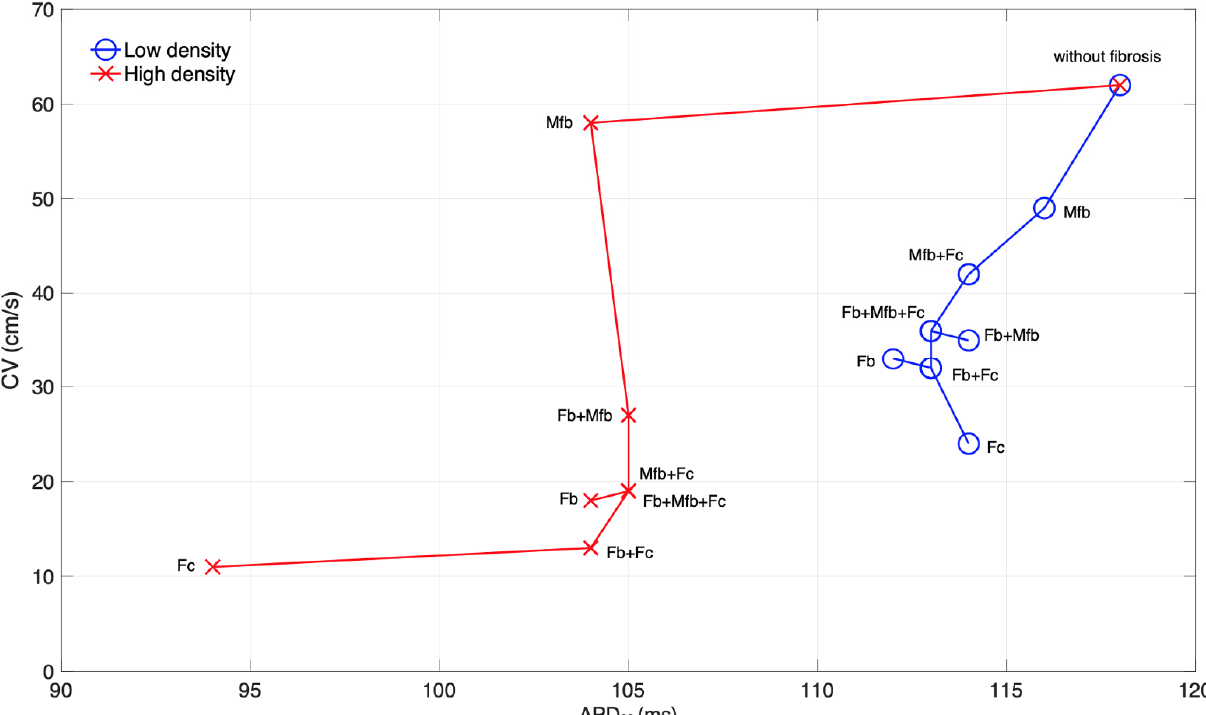
Figure 2. Locus of the conduction velocity (CV) versus APD 90 for the low (blue color) and high (red color). Each point (APD 90 , CV) represents a fibrosis configuration, including the case without fibrosis. For a given fibrosis density, each point is connected by a line to its closest neighbor. All fibrotic cells configurations are included in the chart with the corresponding label. The notation used is Fb, Mfb and Fc for fibroblasts, myofibroblasts and fibrocytes, respectively.